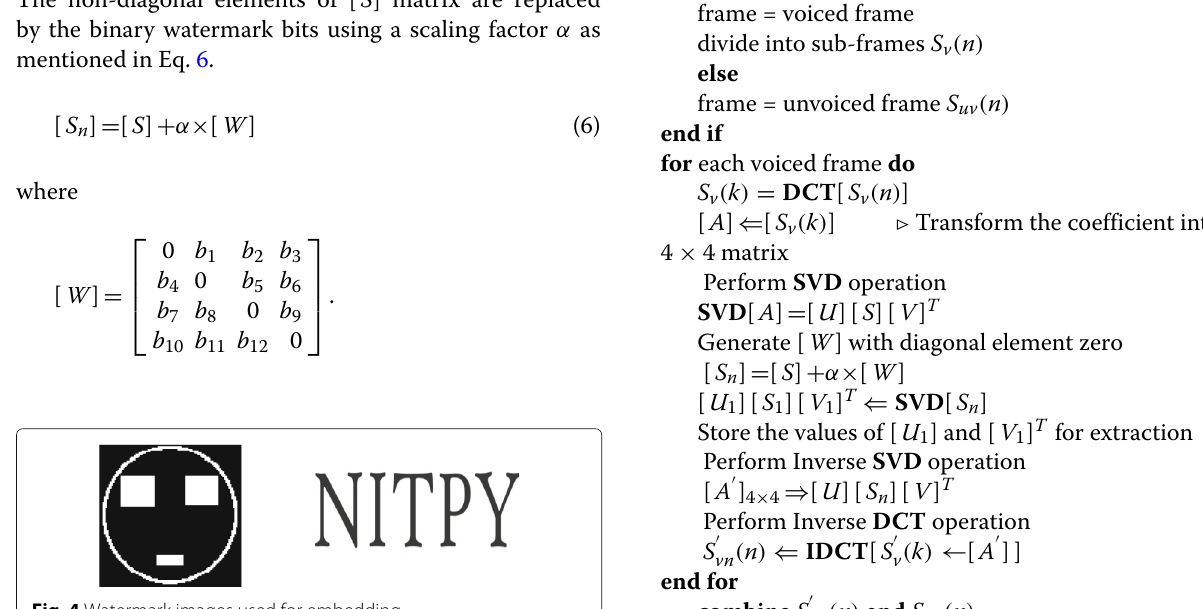
Fig. 4 Watermark images used for